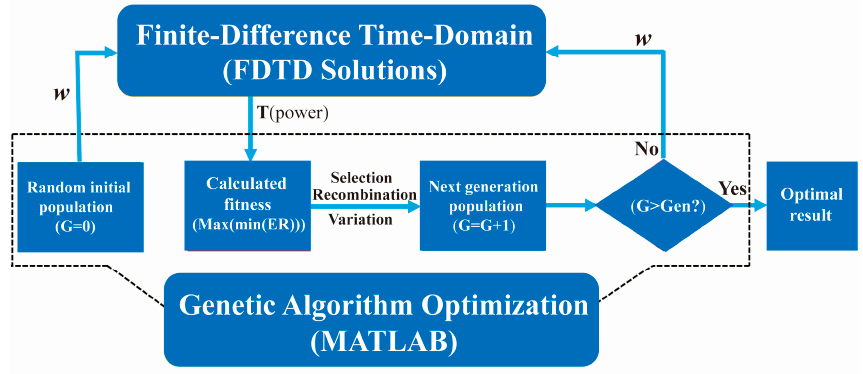
Figure 4. The flow chart of the genetic algorithm (GA) optimization simulation process based on MATLAB and FDTD Solutions.